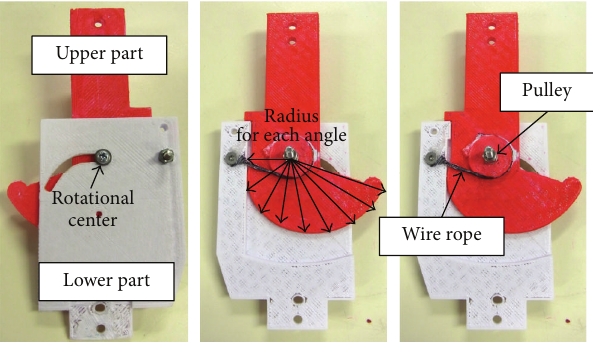
Figure 6: Knee mechanism of the device.